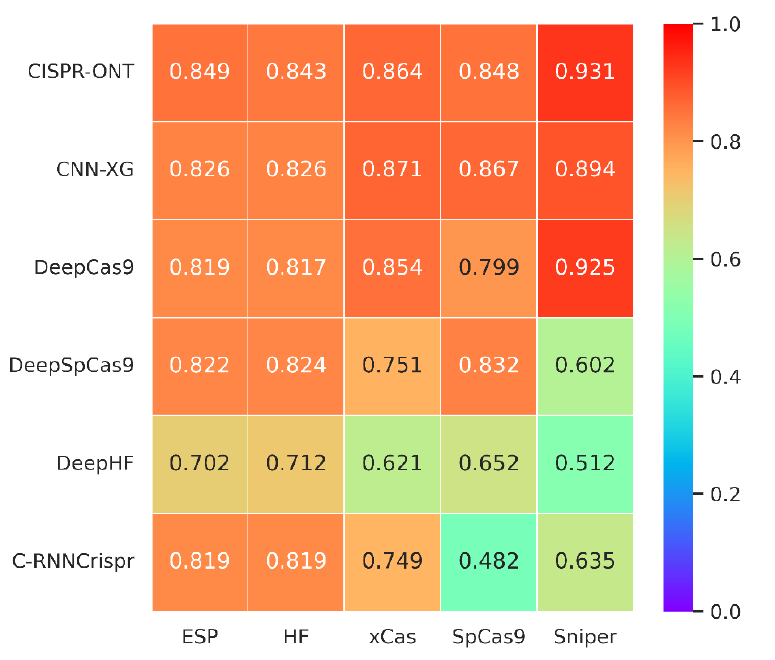
Figure 4. Heatmap of Spearman coefficients between CNN-XG and other recent algorithms on various SpCas9 variants datasets under 10-fold cross-validation. The prediction models are placed vertically, whereas the test sets are arranged horizontally. (The tested spearman coefficients of C-RNNCrispr, DeepCas9 and DeepSpCas9 were derived from CRISPR-ONT [34]).